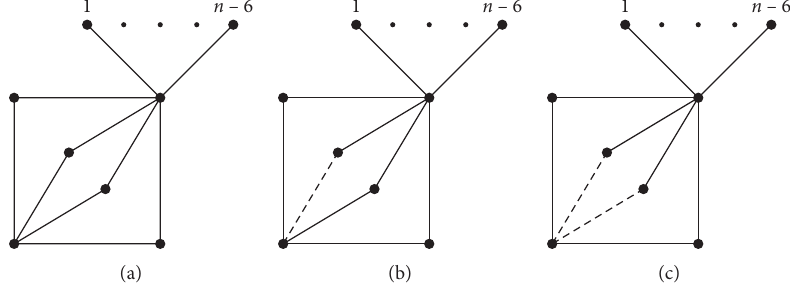
Figure 2: Bipartite tricyclic signed graphs with two vertices on one side. (a) K 1